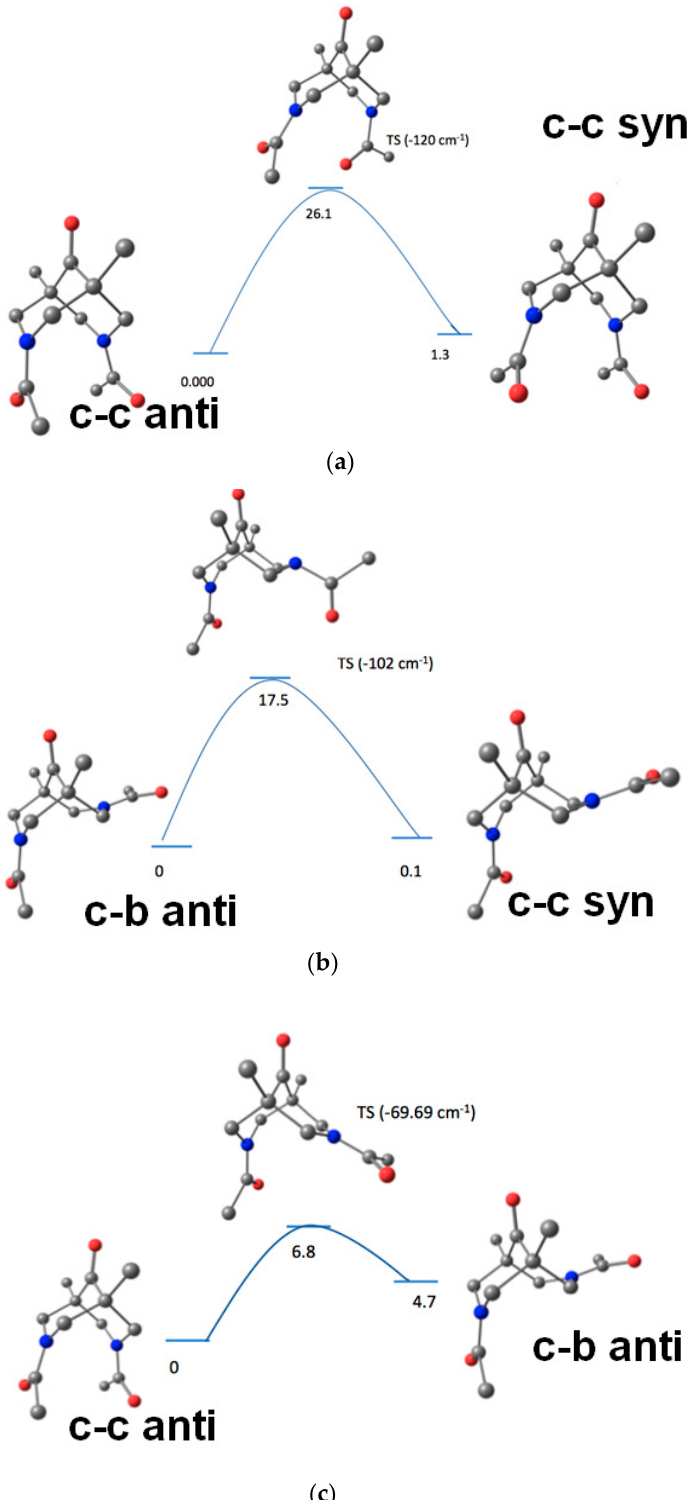
Figure 4. The calculated routes of anti / syn isomerization on the example of 1a : direct amide inversion in the CC conformation ( a ); amide inversion in the CB conformation ( b ); CC–CB transformation ( c ).